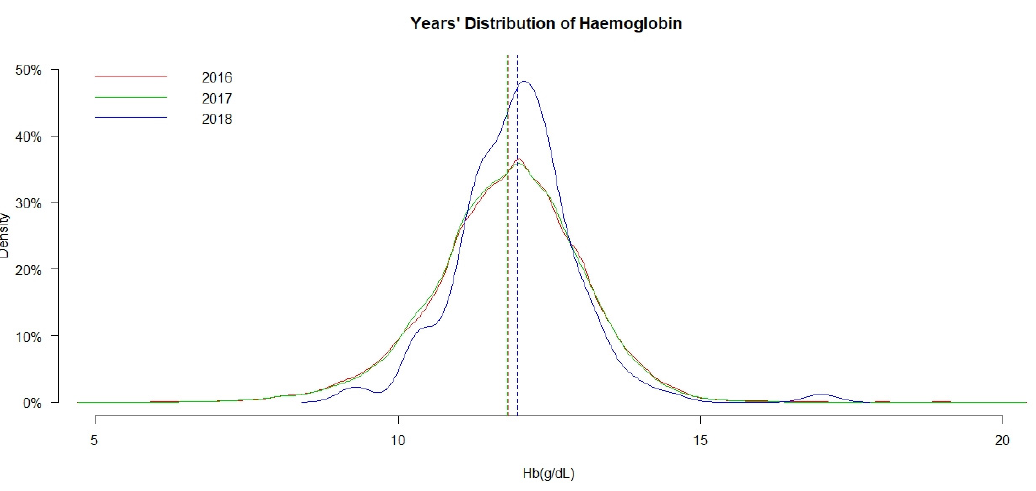
Figure 1. Time trends in the distribution of haemoglobin (Hb) in 2016, 2017, and 2018. Figure 2 shows the density distribution and mean of Hb among 6- to 23-month-old IYC in boys and girls. The color curves show the density distribution of Hb in gender, which were very similar in boys and girls. The colored lines which represent the mean of Hb in different genders almost coincide. The mean Hb of boys and girls was 11.84 ± 1.23 g/dL and 11.85 ± 1.21 g/dL, respectively, and the mean was not significantly different in each gender (F = 5.672, p = 0.017).